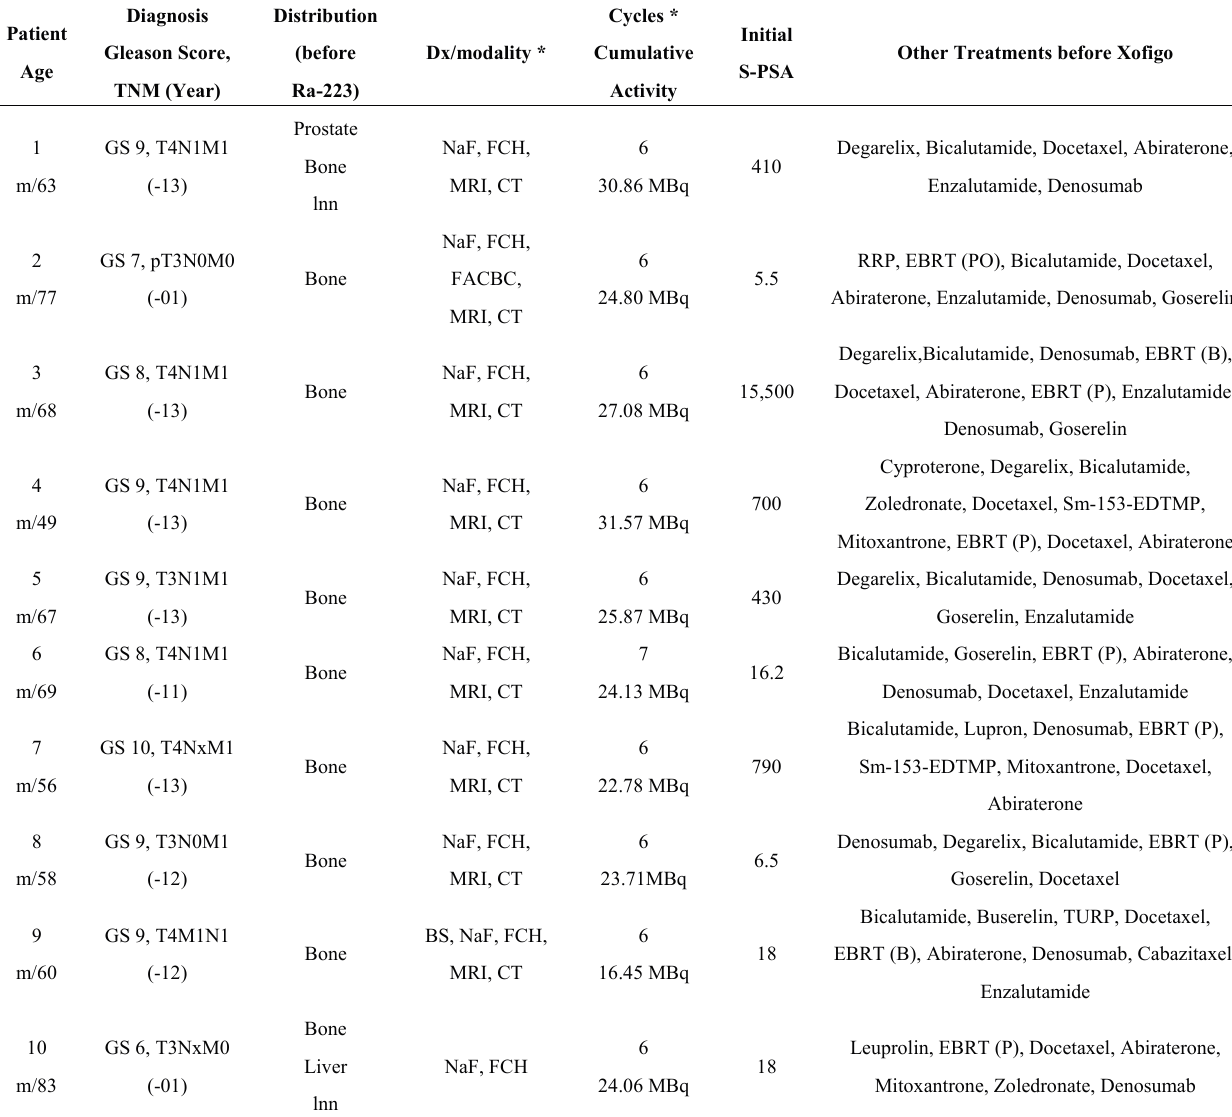
Table 1. The patient